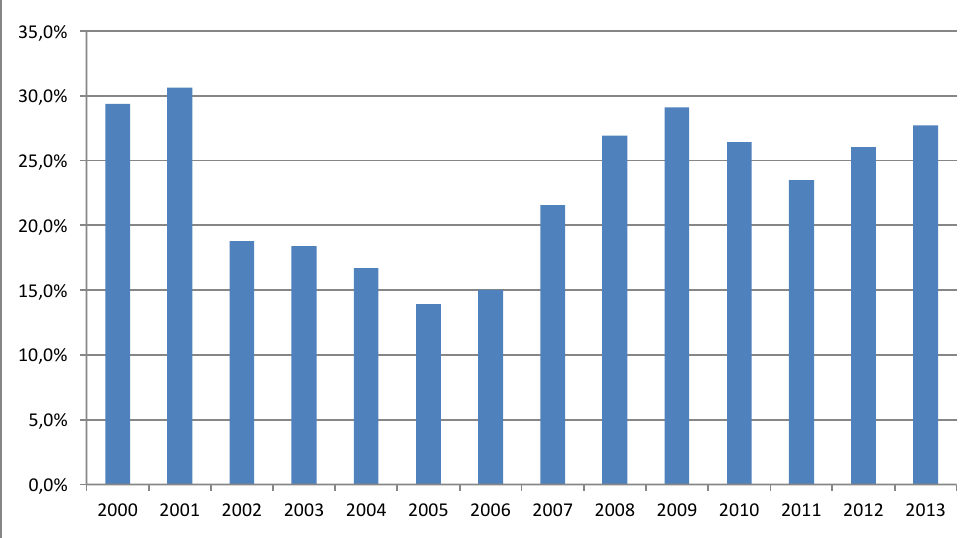
Figure 14 Non-residential buildings completed as percentage of total